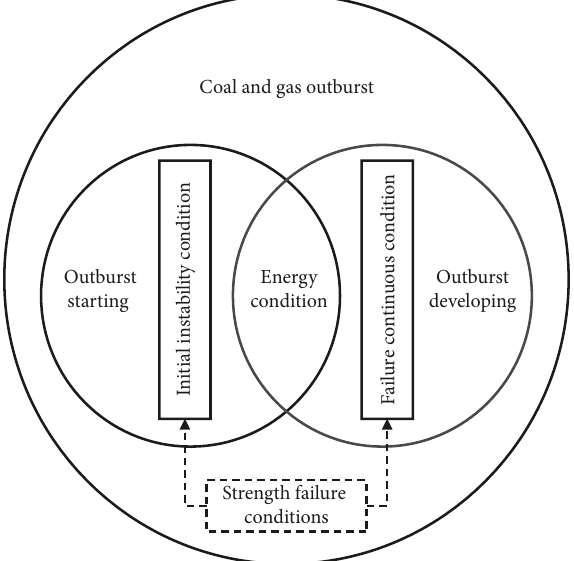
Figure 1: The conditions for coal and gas outburst